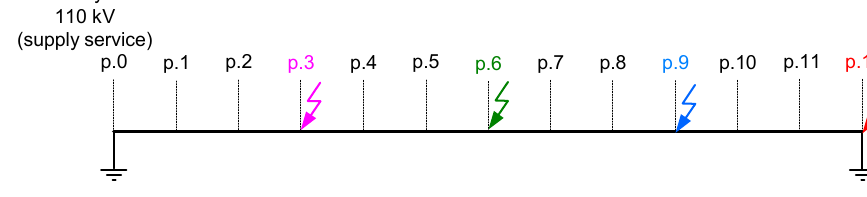
Figure 9. Simplified diagram of the cable system presenting points of the assumed consecutive line-to-earth faults.